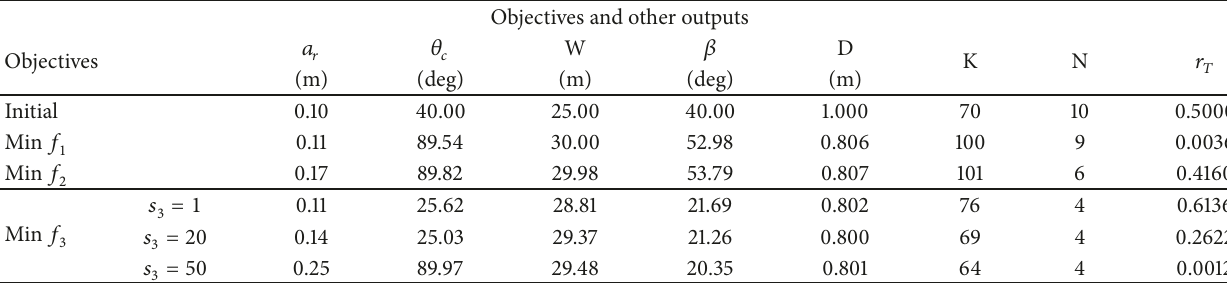
(a) Initial design and single-objective optimization results (design